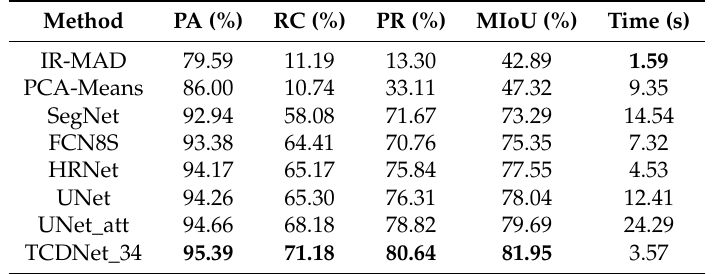
Table 4. Comparison between different algorithms (bold represents the best